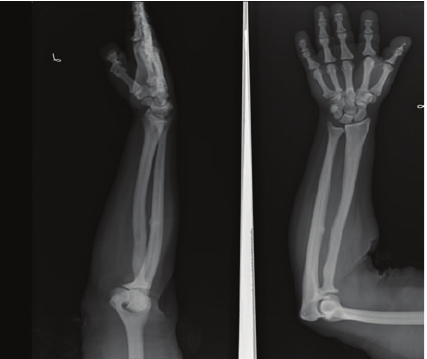
Figure 3: X-ray showing sclerosis of terminal